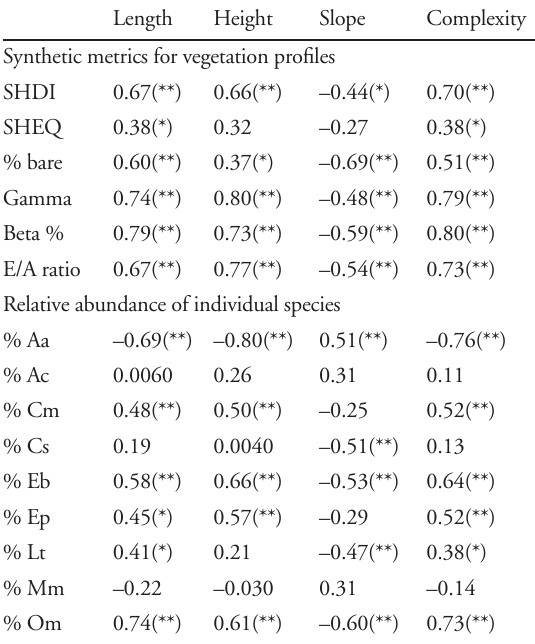
Table 4. Correlations (Spearman’s rho) between topographic and vegetation attributes of the 30 profiles. (See Table 1 for codes and attributes and Appendix 1 for codes of plant taxa.). (**) = p < 0.01, (*) = p < 0.05. Length Height Slope Complexity Synthetic metrics for vegetation profiles